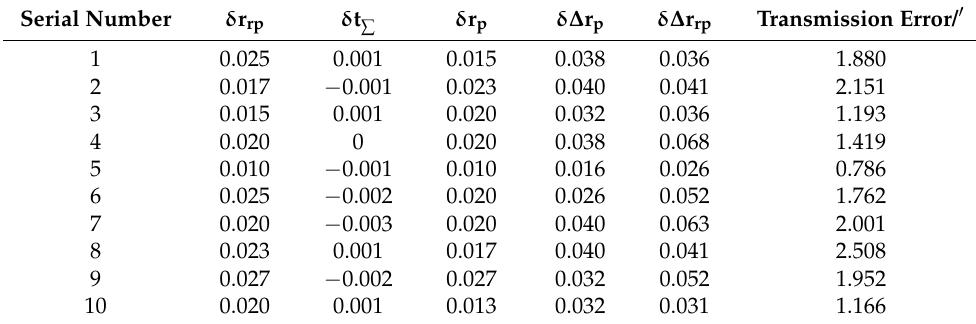
Table 2. Some sample data example